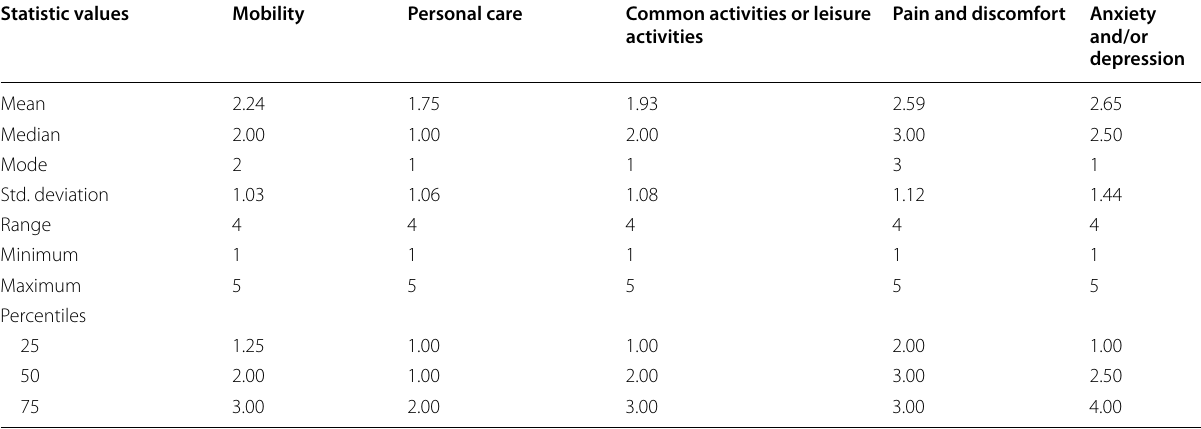
Table 3 Mean scores for the dimensions of quality of life-related to the health of patients on hemodialysis Statistic values Mobility Personal care Common activities or leisure